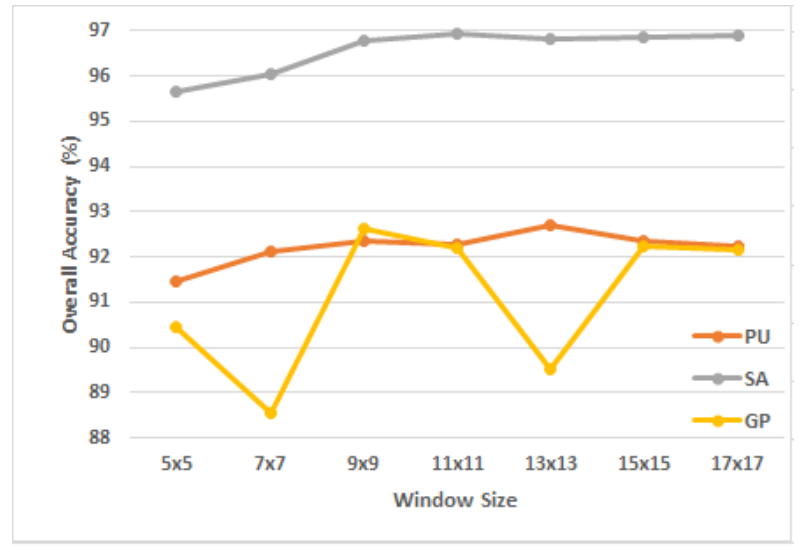
Figure 5. The OA of the proposed model using different values of window size in the three datasets.